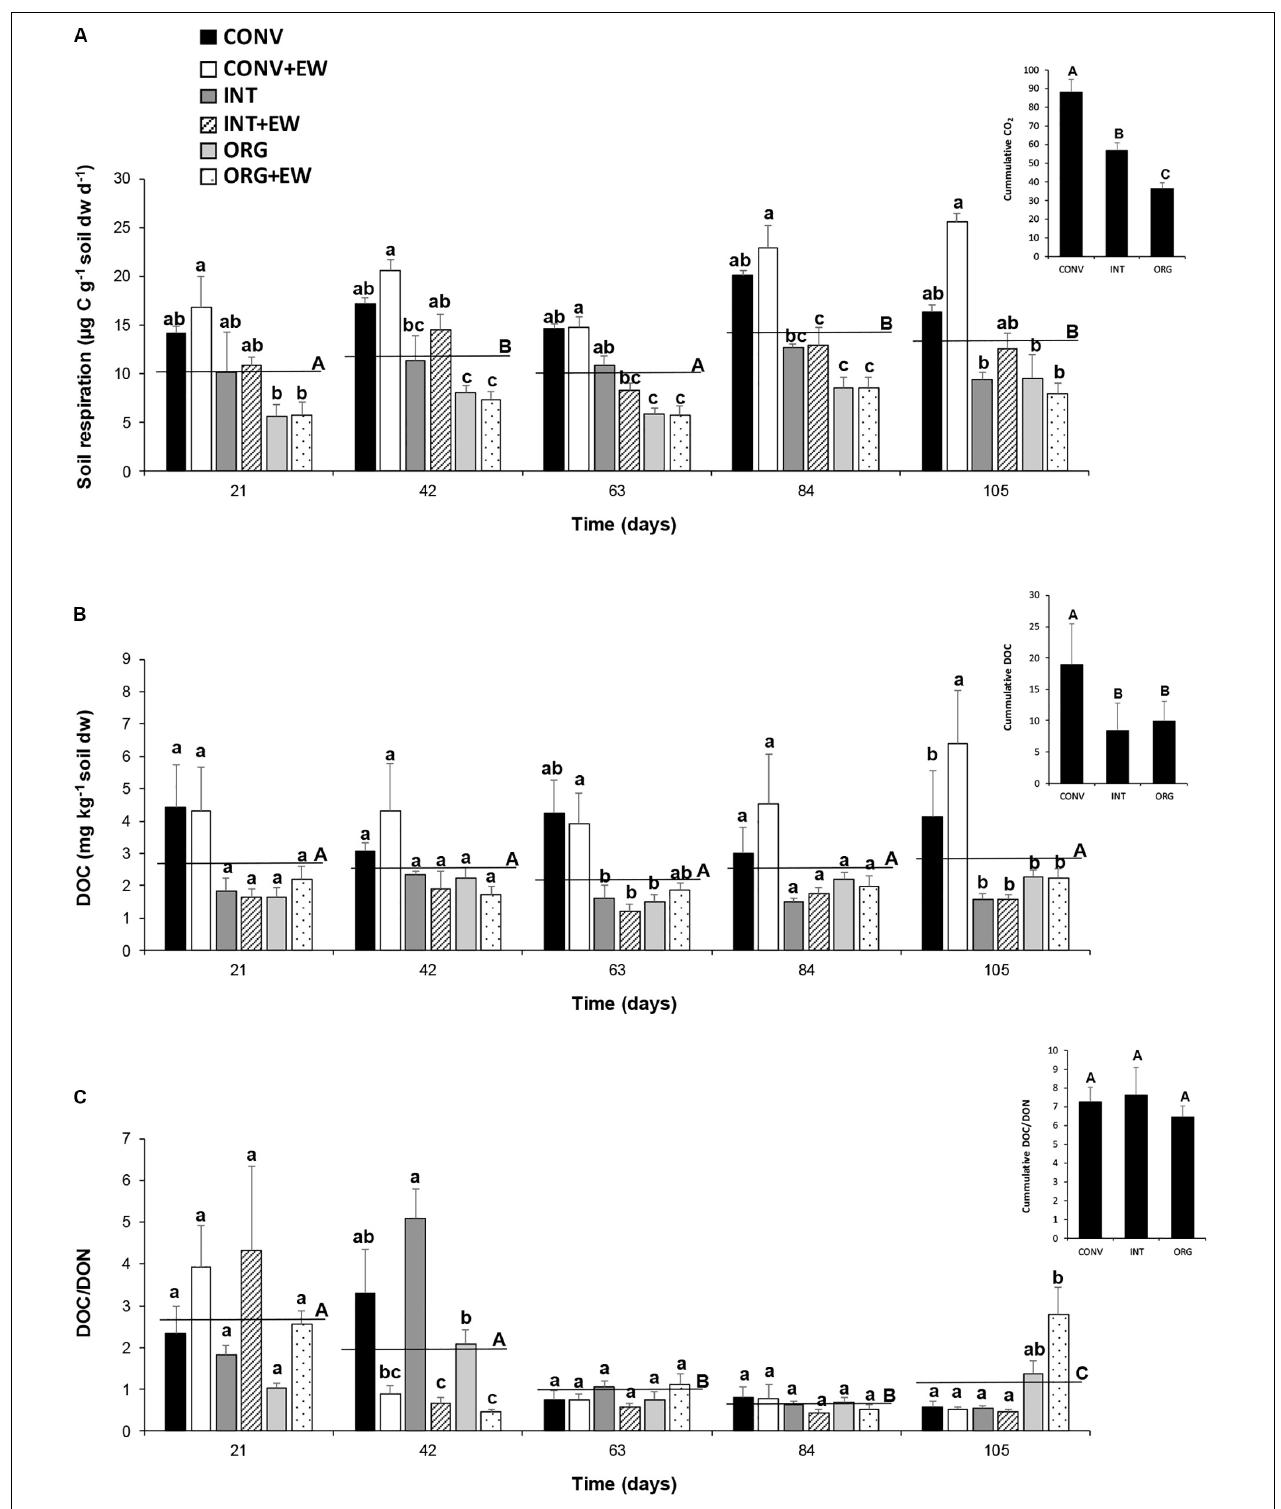
FIGURE 4 | Changes in the average values of soil respiration ( µ g C g − 1 soil dw d − 1 ) (A) , DOC (mg kg − 1 soil dw) (B) , and DOC/DON ratio (C) measured at each treatment (agricultural management and earthworm conditions combined) during the incubation period together with the averaged values per sampling time (horizontal lines) and the accumulated values (inset). Different letters represent significant differences (repeated measures ANOVA) between treatments per sampling date (lower case) and between successive sampling times (upper case) and between treatments (ANOVA; insets).